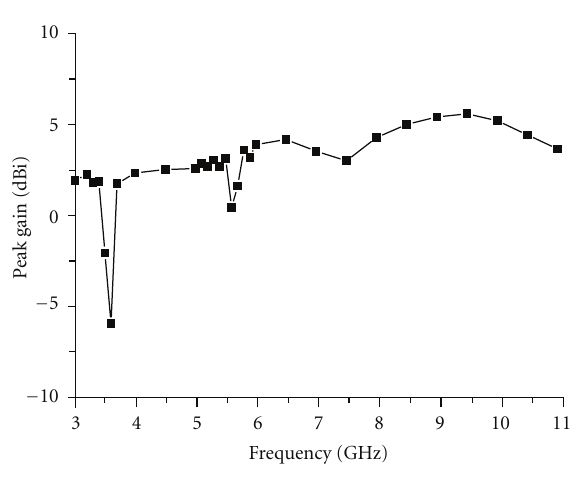
Figure 11: Peak gain of the proposed